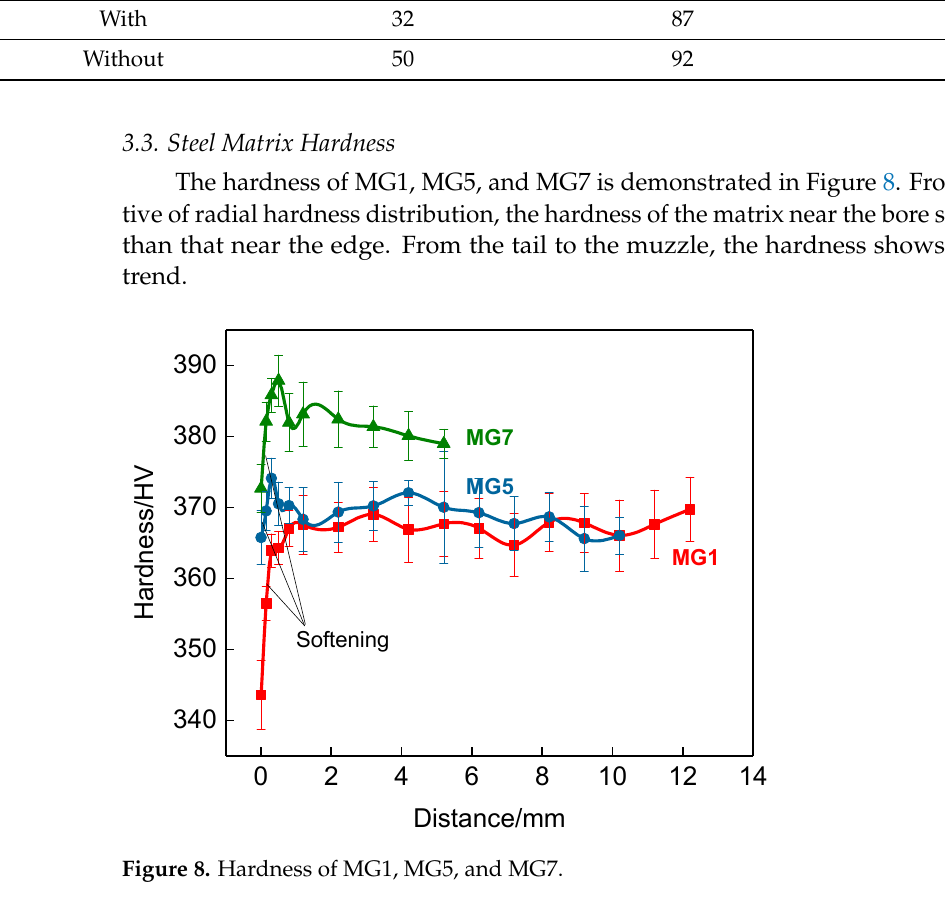
Table 2. Experimental values of crack depth and spacing in a cross-sectional matrix.